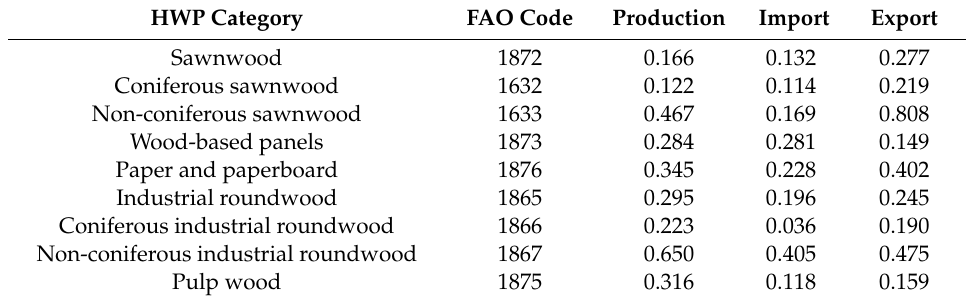
Table 3. The share of Slovakia on harvested wood products categories in the period